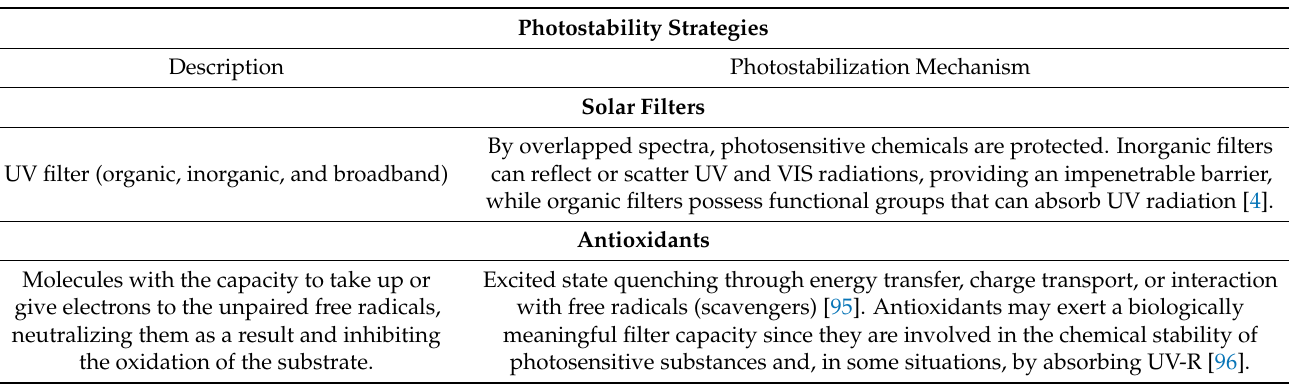
Figure 8. The interaction of organic and inorganic UV filters from sunscreen formulation with UV light. The organic UV filter undergoes conformational changes after UV exposure, followed by heat release. The organic UV filter works through the reflection, scattering or absorption of UV light. Table 2. Summary of the photostabilization strategy